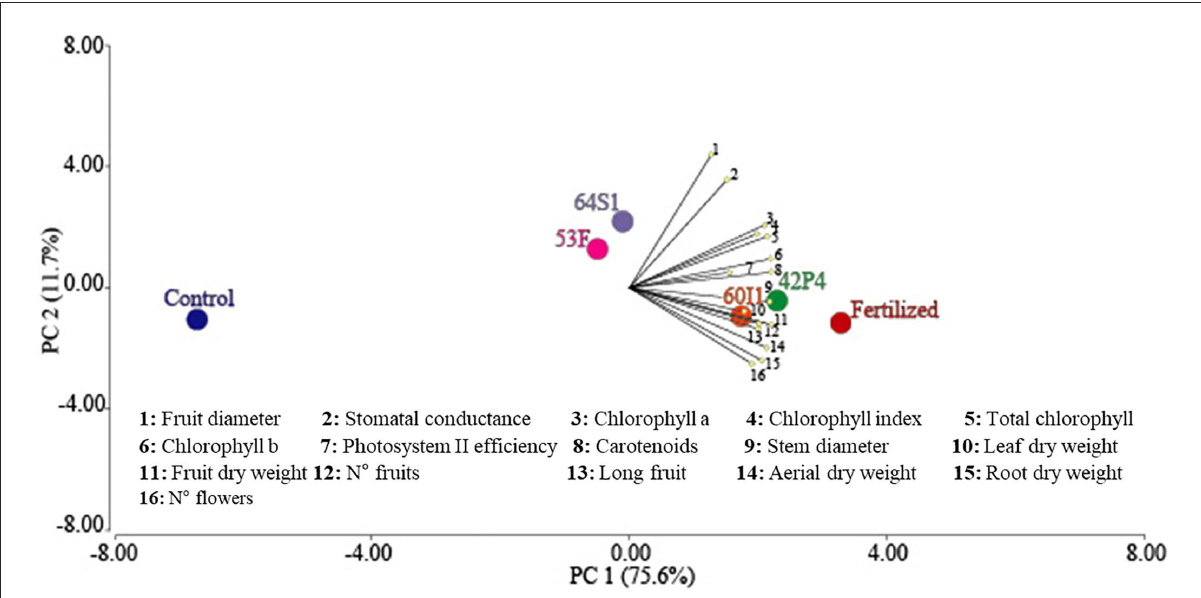
FIGURE6 Biplot of principal components analysis of the effect of PGPR strains on the parameters evaluated in pepper plants grown in pots under greenhouse conditions.